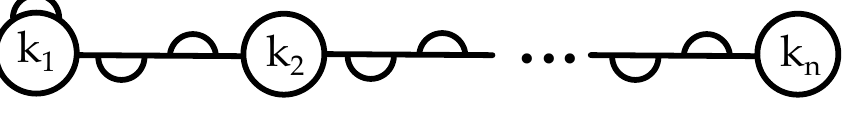
Figure 8 . Quiver corresponding to (cid:10)